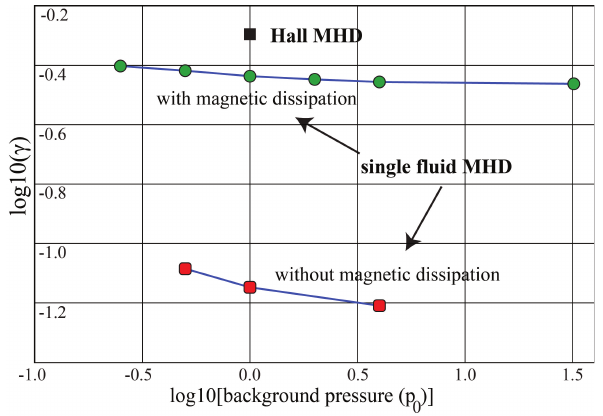
µ e = ν = 5 × 10 − 6 ). The corresponding normalized i